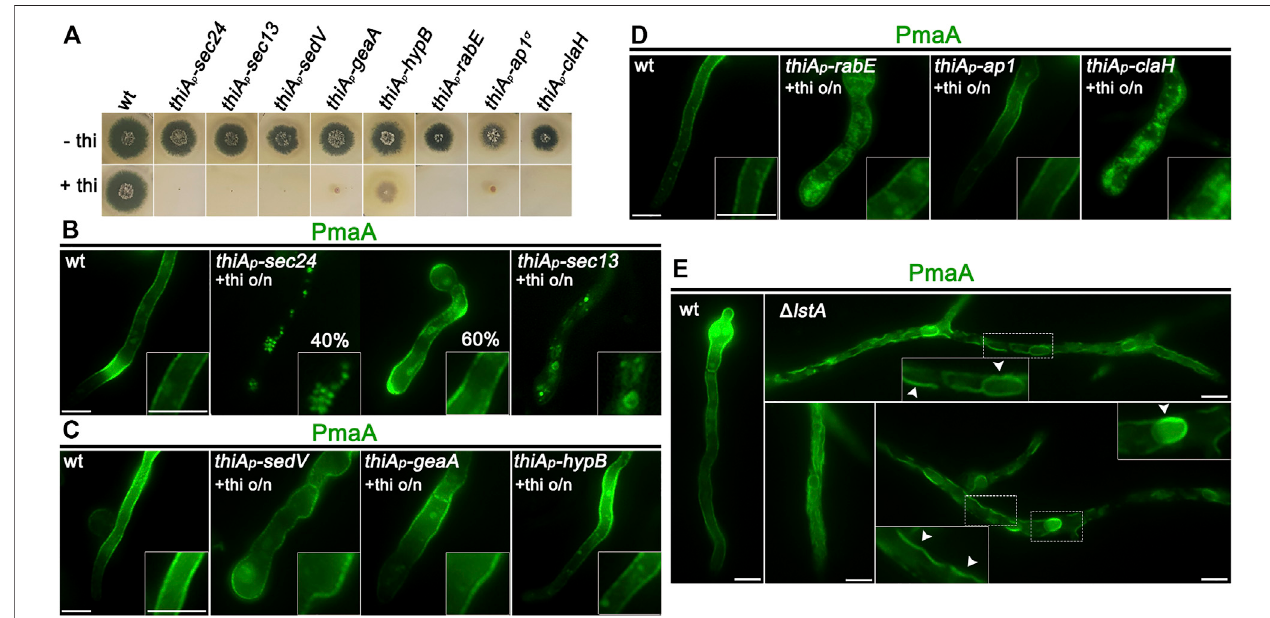
FIGURE 3 | Subcellular localization of neosynthesized PmaA in traf fi cking mutant backgrounds. (A) Growth tests showing that, under repressing conditions (presence of thiamine in the growth medium), strains selected to follow the de novo expression of PmaA-GFP do not form proper colonies, con fi rming that all genes expressed under the thiA p promoter are tightly repressed. Under derepressing conditions (absence of thiamine from the growth medium), all strains grow almost as the isogenicwild-typecontrolstrain(upperrow). (B) Epi fl uorescencemicroscopicanalysisof denovo -madePmaA-GFPinstrainswhere sec24 and sec13 transcription is ab initio repressed by thiamine. o/n (overnight) means addition of thiamine from the onset of germination. The total lack of PM-associated signal of PmaA under conditionsofSec13repressionisnoted,whileSec24repressionaffectstheER-exitofPmaAinonly~40%ofthecellpopulation(n=92). (C) Epi fl uorescencemicroscopic analysis of de novo -made PmaA-GFP in strains where sedV , geaA , or hypB transcription is ab initio repressed by thiamine. It is noted that repression of these key Golgi proteins does not affect at all the proper localization of PmaA-GFP to the PM. (D) Epi fl uorescence microscopic analysis of de novo -made PmaA-GFP in strains where rabE , ap-1 σ ,or claH transcriptionis abinitio repressedbythiamine.Noticethatwhen rabE or ap-1 σ isrepressed,PmaA-GFPstillreachesthePM,butinthelatter,thereis a clear accumulation of membranous cytoplasmic structures. Repression of claH totally abolishes the labeling of the PM and leads to PmaA retention in the cytosolic membrane or aggregates. (E) Epi fl uorescence microscopic analysis of de novo -made PmaA-GFP in strains where lstA is knocked out. In this case, PmaA fails to reach the PM and remains instead in the ER. The accumulation of PmaA inside the cortical ER and perinuclear ER rings is noted, as highlighted by white arrows.